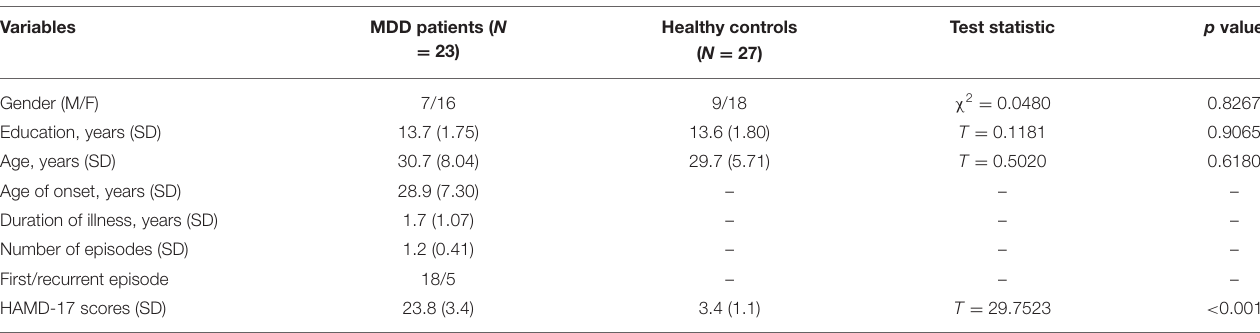
TABLE 1 | Demographic and clinical data of MDDs and healthy